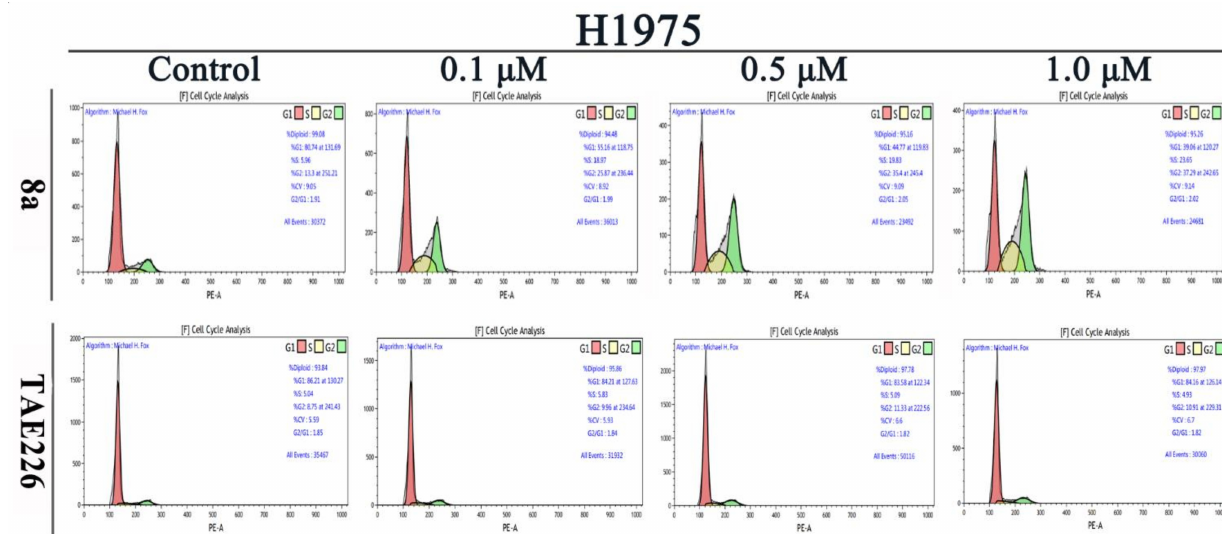
Figure 7. Cell cycle analysis of H1975 cells treated with 8a and TAE226 (0.1, 0.5, 1 µ M) for 48 h by flow cytometry assay.